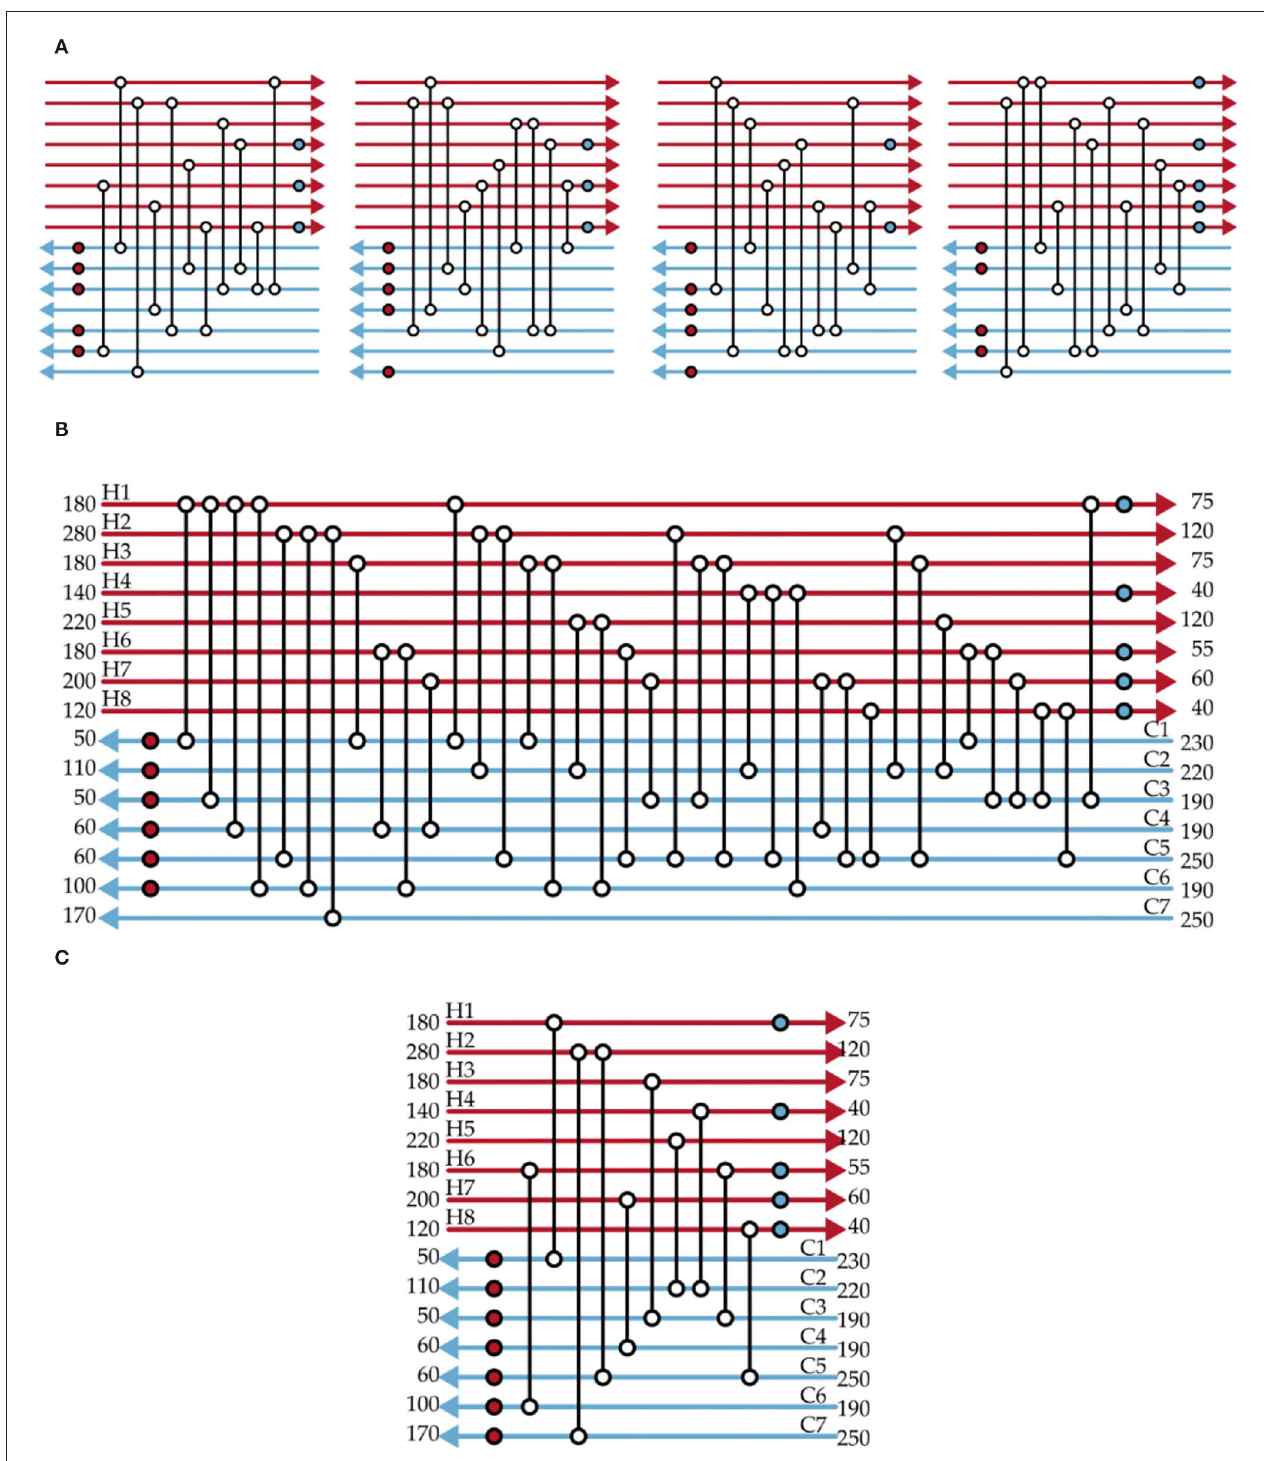
FIGURE 3 | Topologies for period individual solutions, merged solution, and final solution. (A) individual refined topologies for periods 1–4. (B) Multiperiod HEN topology merged from individual single-period refined solutions. (C) Refined multiperiod HEN topology.